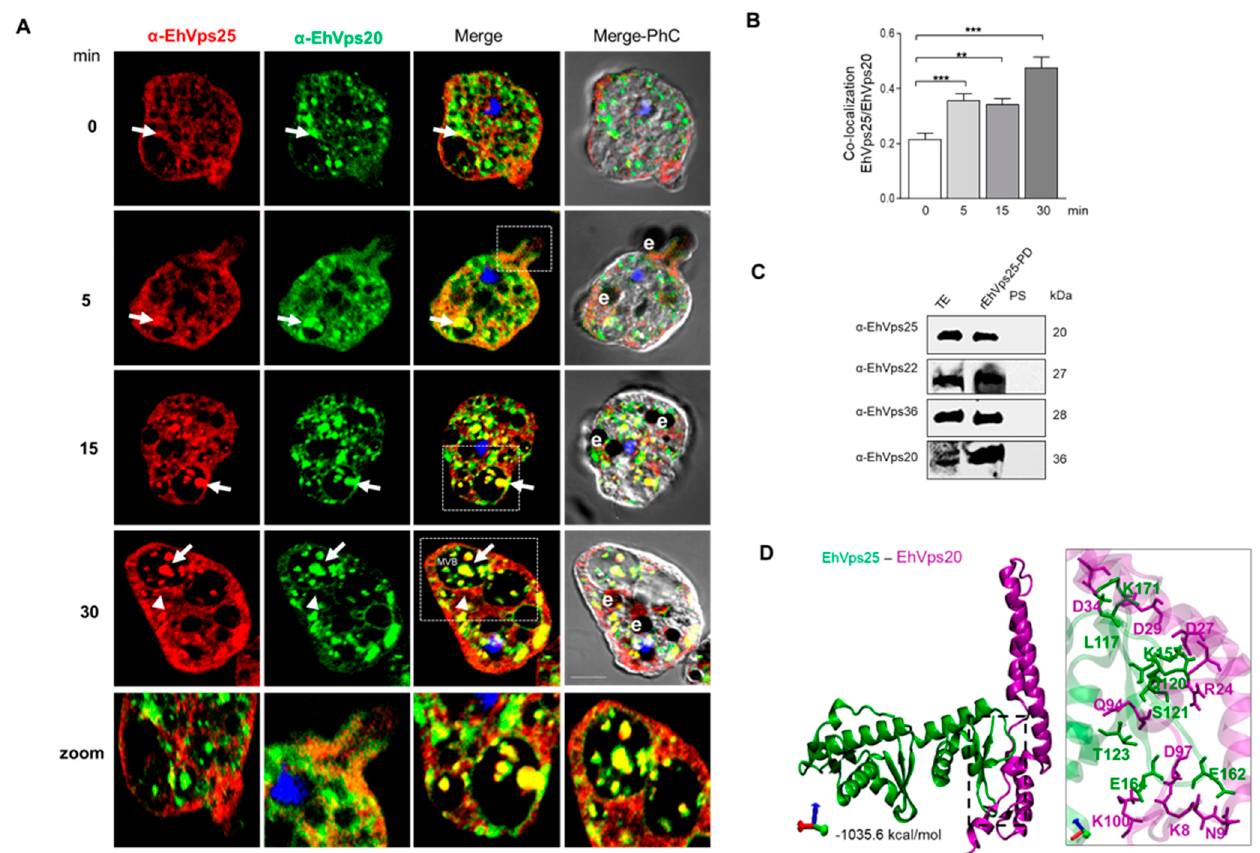
Figure 7. Co-localization of EhVps25 (ESCRT-II) and EhVps20 (ESCRT-III) during phagocytosis. ( A ) Confocal images of trophozoites treated with α -EhVps25 (red) and α -EhVps20 (green) antibodies. The nucleus was stained with DAPI (blue). PhC: phase contrast images. Arrows: protein co-localization. Zoom: magnification of the region marked with white squares. Bar = 10 µm. ( B ) Pearson’s coefficient of EhVps25 and EhVps20 co-localization (**) p < 0.01, (***) p < 0.001. ( C ) Western blot assay of pull-down assays using α -EhVps25, α -EhVps22, α -EhVps36 and α -EhVps20 antibodies and extracts from trophozoites in basal conditions. TE: total extracts; rEhVps25-PD: pull-down sample PS: pre-immune serum. Numbers at the right: molecular weights. ( D ) Molecular docking between EhVps25 and EhVps20. The box shows a magnification of the putative interacting amino acids.